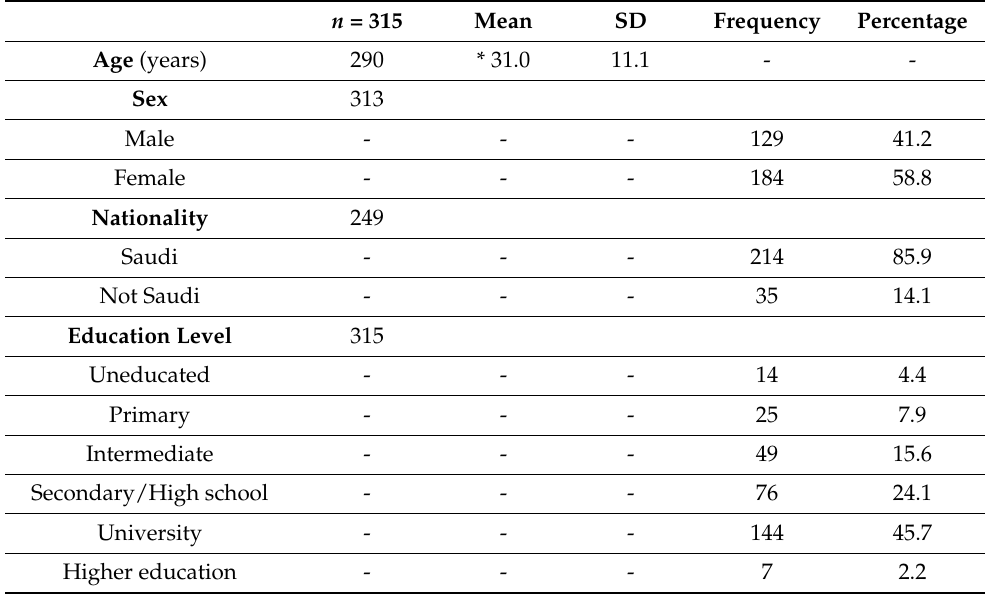
Table 1. Demographics of participating dental